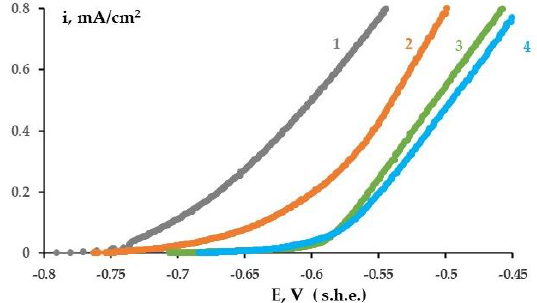
Figure 4. Anodic polarization curve of zinc. 1 — non-modified zinc, 2 — zinc modified with a VS solution, 3 — zinc modified with a solution of a (VS + AS) mixture, 4 — zinc modified with a solution of a (VS + BTA) mixture. Table 3. The effect of zinc surface modification on the value of pitting potential.